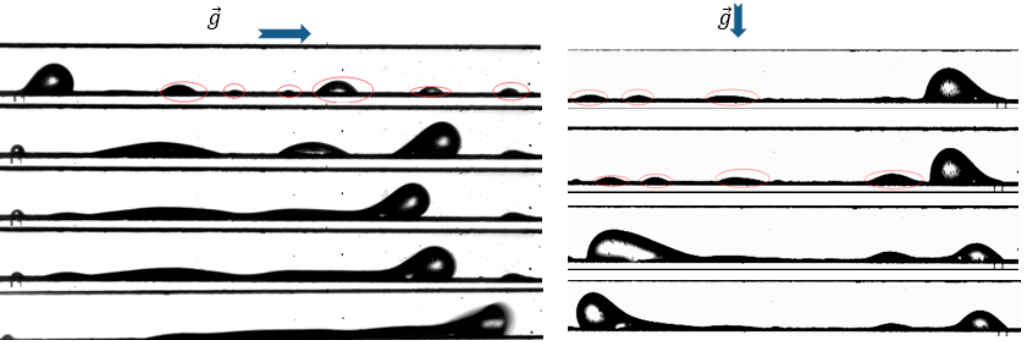
Figure 12. Visualization of liquid film formation in air flow.